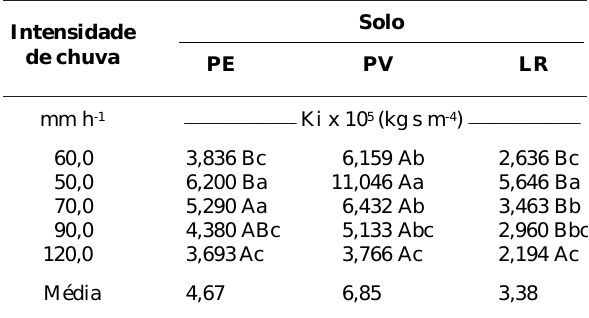
Quadro 1. Valores médios observados de erodibili- dades entressulcos (K ) para o PE, o PV e o LR i